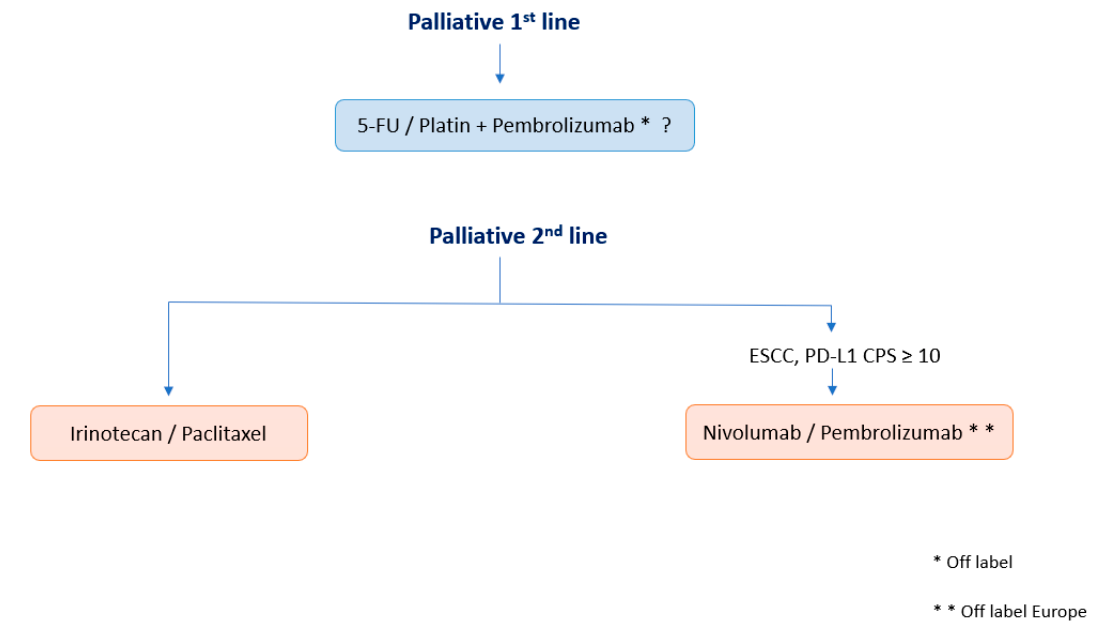
Figure 3. Overview of a possible algorithm for palliative therapy regimes in oesophageal cancer.